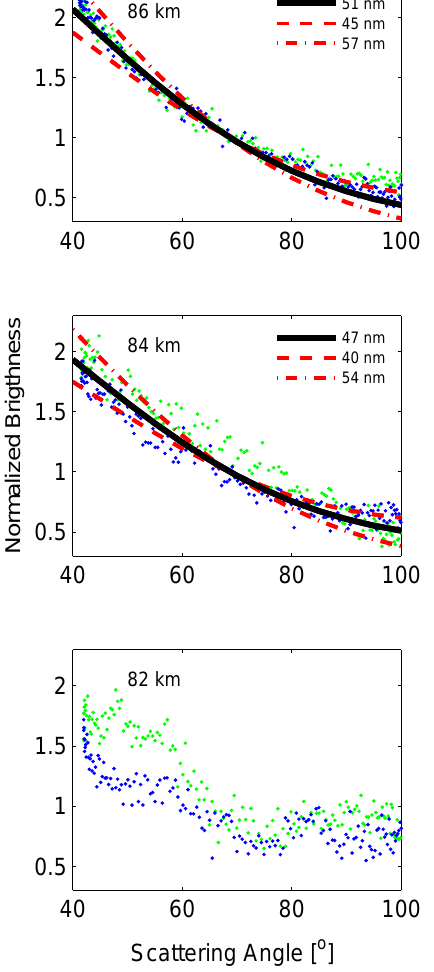
Fig. 4. Scattering phase functions for the three layers of the NLC observed on MASS1. The lines show the theoretical phase function from a monodisperse distribution of spherical particles of various radii. For the layer centred at 82 km the inhomogeneity of the cloud layer prevents particle size retrieval.